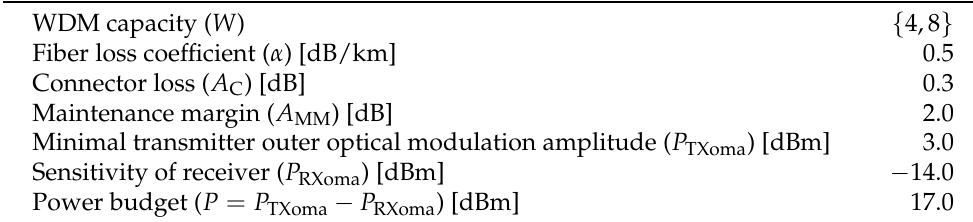
Table 2. Assumed values of the transmission system